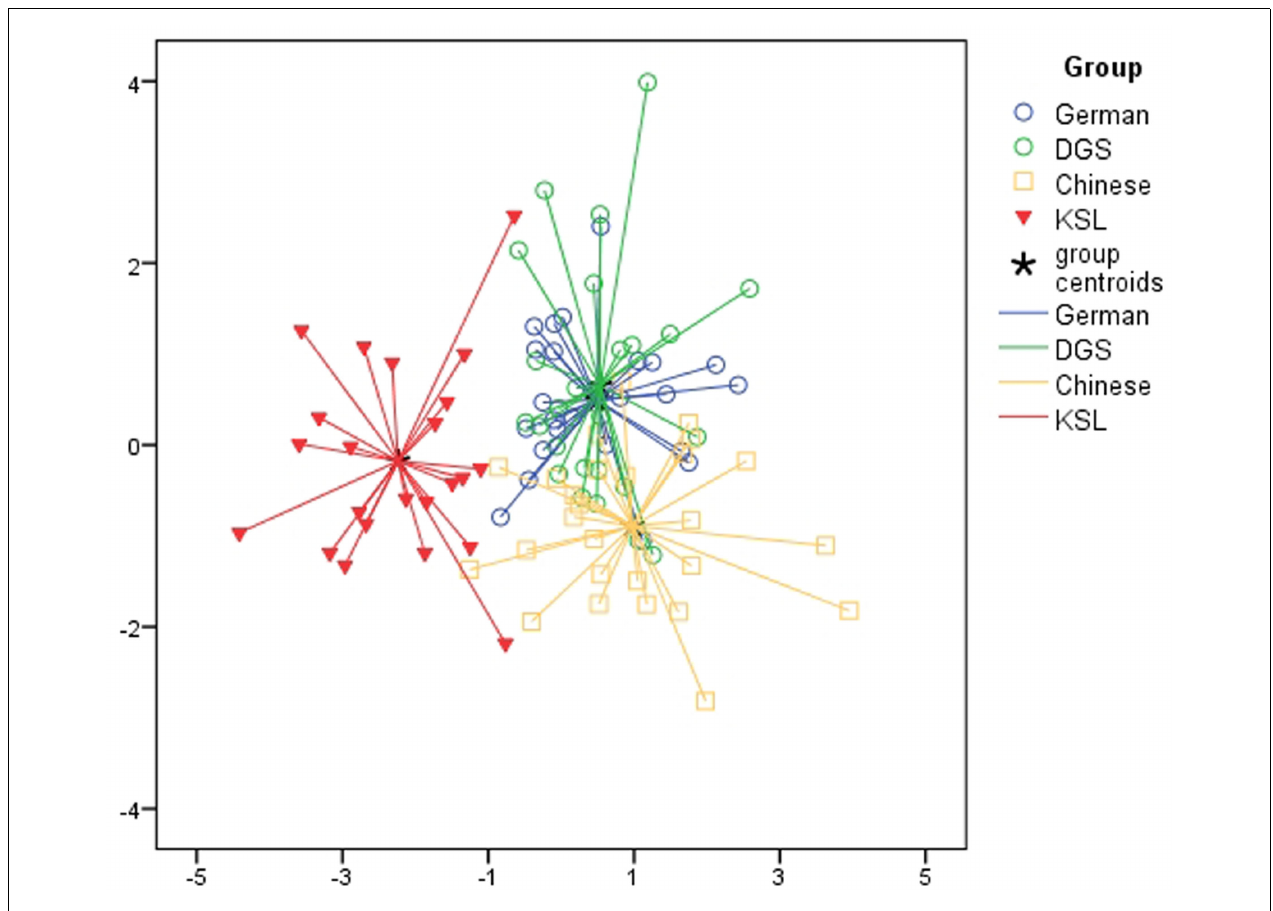
space. Note that hearing Germans and deaf German signers, who have the least discriminable RT-profiles in a magnitude comparison task with Arabic digits, also have very similar finger-counting systems (see Figure 2